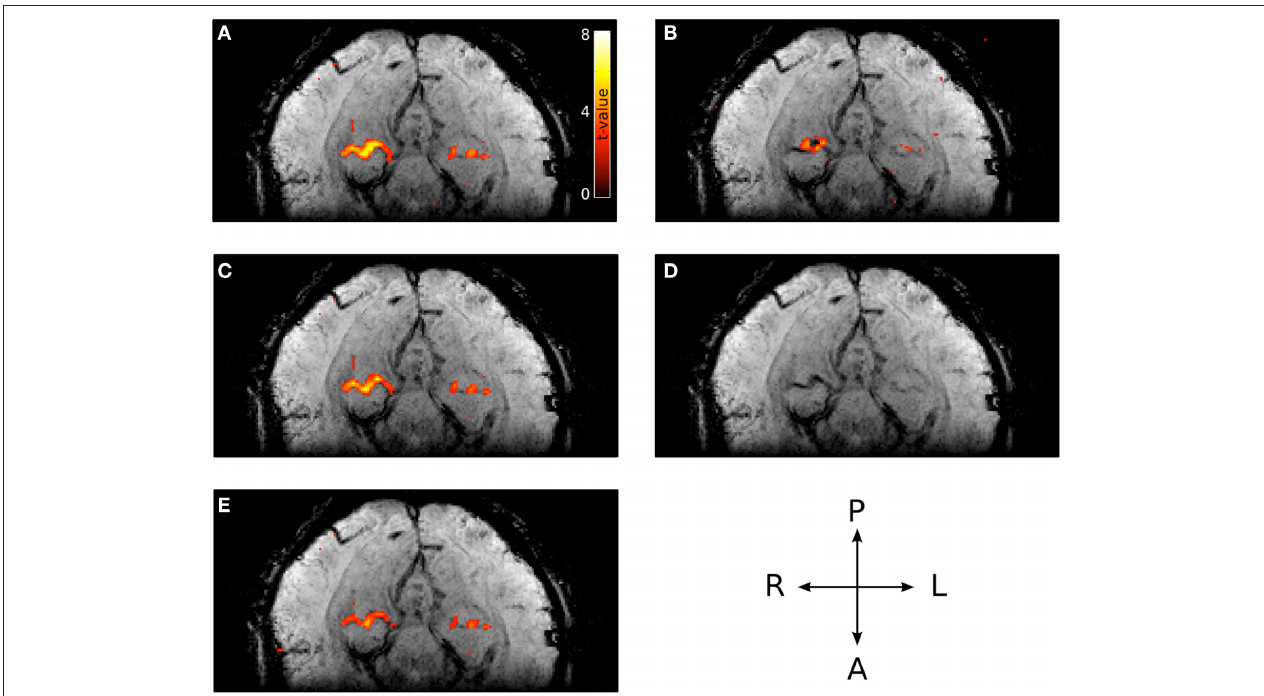
FIGURE 8 | Typical PPA t -values with and without large vein suppression overlaid on the corresponding venogram. (A) Magnitude t -values. The majority of right PPA coincides with a large vein. (B) Phase t -values (absolute value shown to account for opposing susceptibility gradient polarities around the vein). The majority of high phase t -valued voxels lie adjacent to the vein. (C) Large vein suppressed t -values using sPR with a one-voxel-neighborhood (e.g., the original PR method with OLS cost function). In this regime, sPR very minimally suppresses the large vein contributions to right PPA because most of the high phase t -values lie adjacent to the vein. (D) Corresponding venogram slice. (E) Large vein suppressed t -values using sPR with the full seven-voxel-neighborhood. In this regime, sPR utilizes the phase component of the BOLD activity from neighboring voxels to correctly suppress the large vein contributions to right PPA. The vein contributing to left PPA is too small to be suppressed using sPR.